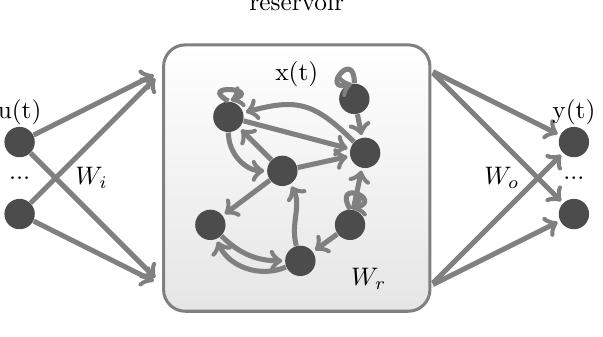
Figure 1. Structure of